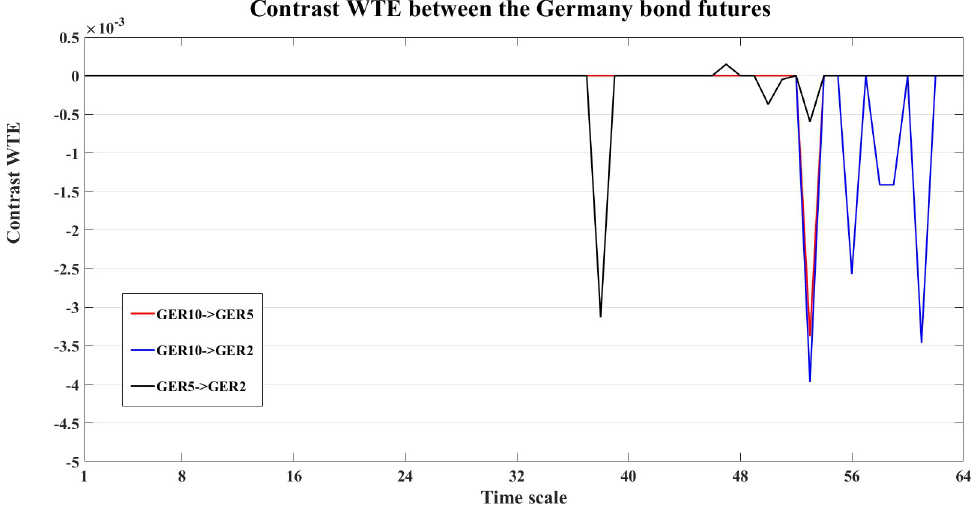
Fig 34. The contrast WTE information transfer values for the Germany bond futures. The line graphs show the contrast WTE values between the Germany bond futures at different time scale s i (i = 1,2, ... 64).